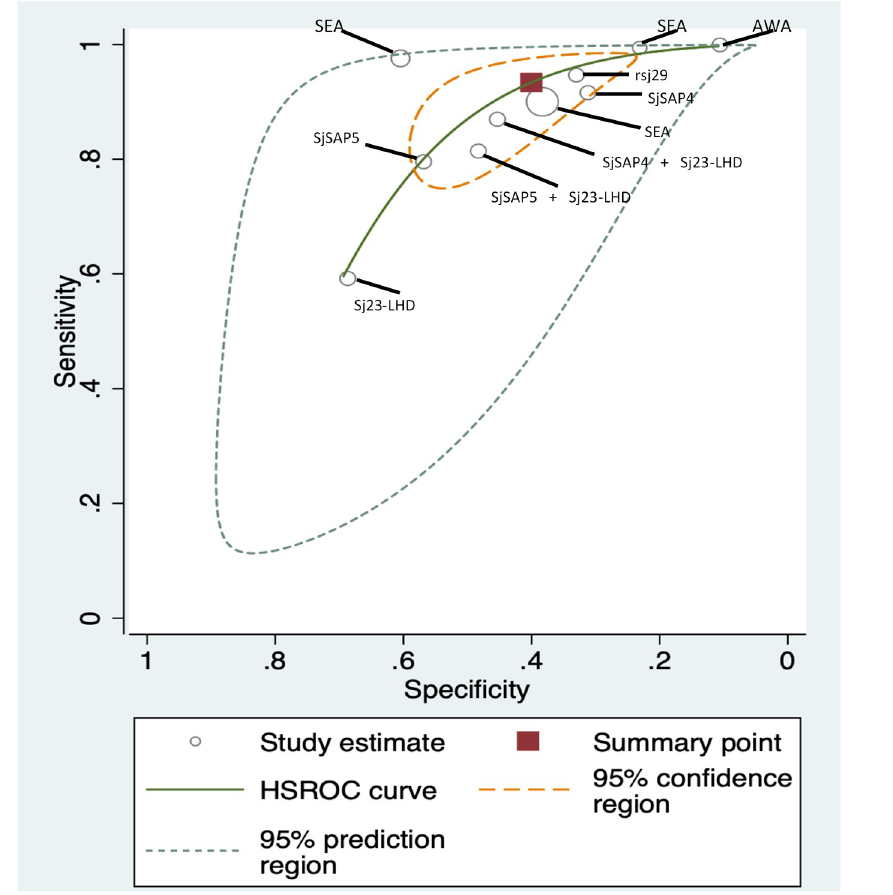
Fig 5. HSROC curve for ELISA ( S . japonicum with stool examination as a reference standard).